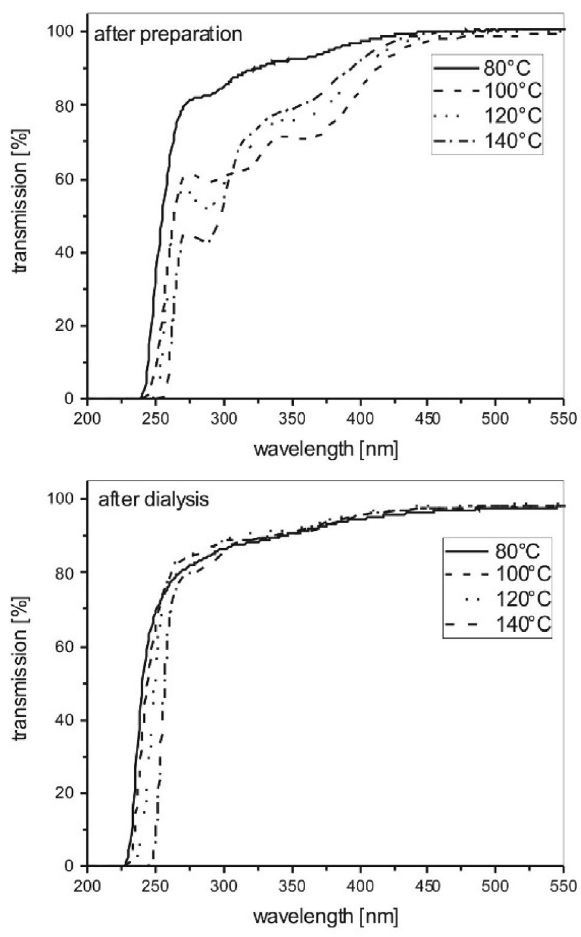
Figure 4. UV/Vis-transmission spectra of the prepared solution recorded directly after preparation (image above) and after treat- ment by dialysis (image below). Presented are spectra from solu- tions prepared at different process temperatures with a process duration of 5 min.